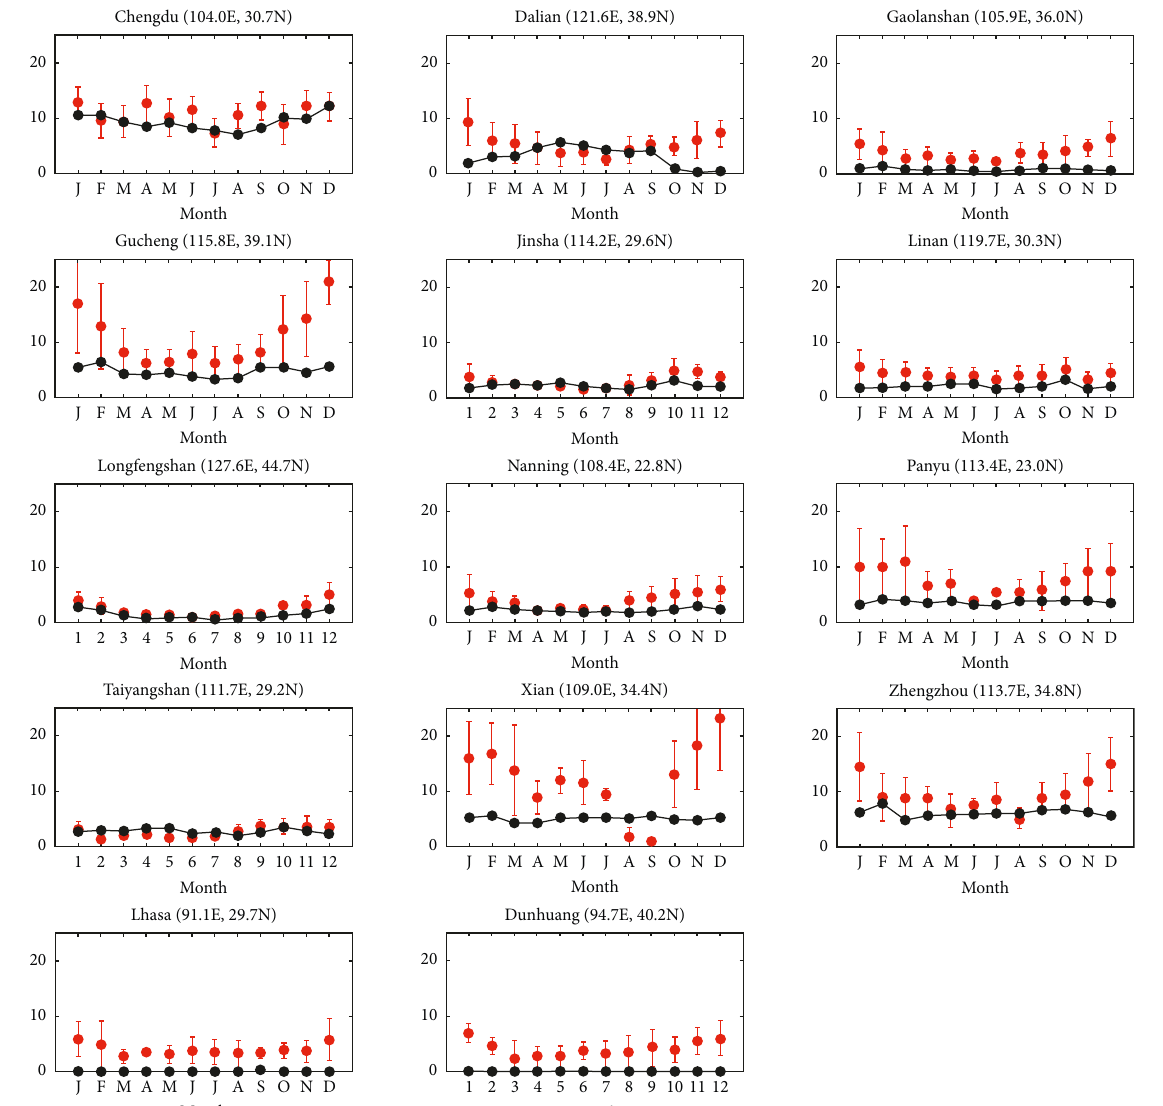
Figure 6: Comparison of the observed and simulated monthly changes in the BC aerosol concentrations ( μ g/m 3 ) in different regions of China. The black dotted lines represent the simulated BC aerosol ground surface concentrations, the red dots represent the observations, and the red vertical line segments represent the standard deviations.